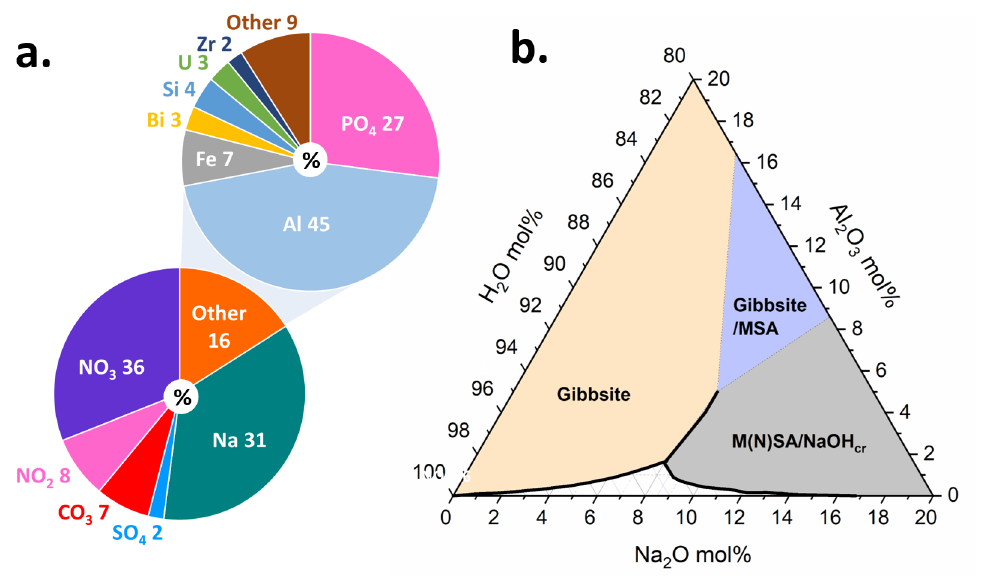
Figure 5. ( a ) Composition estimate for Hanford tank waste, which shows relatively high proportions of Na and Al. Data adapted from Ref. [66]. The composition of the waste can promote crystallization and aggregation of Al hydroxides. ( b ) Na 2 O-Al 2 O 3 -H 2 O ternary phase diagram showing solubility region as well as regions saturated with respect to gibbsite, gibbsite/monosodium aluminate hydrate, and monosodium aluminate hydrate/nonasodium bis(hexahydroxyaluminate) trihydroxide hex- ahydrate/sodium hydroxide. Data adapted from Refs. [67–69]. The composition of the tank waste promotes formation of some of these species. While previous radiolysis studies have focused on pure water, future studies will increase in complexity and explore compositions within the phase